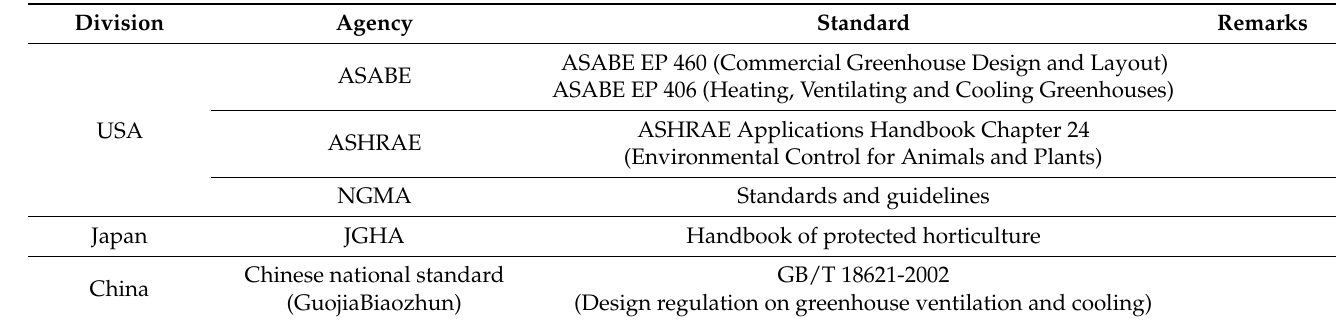
Table 3. Current status of overseas greenhouse design